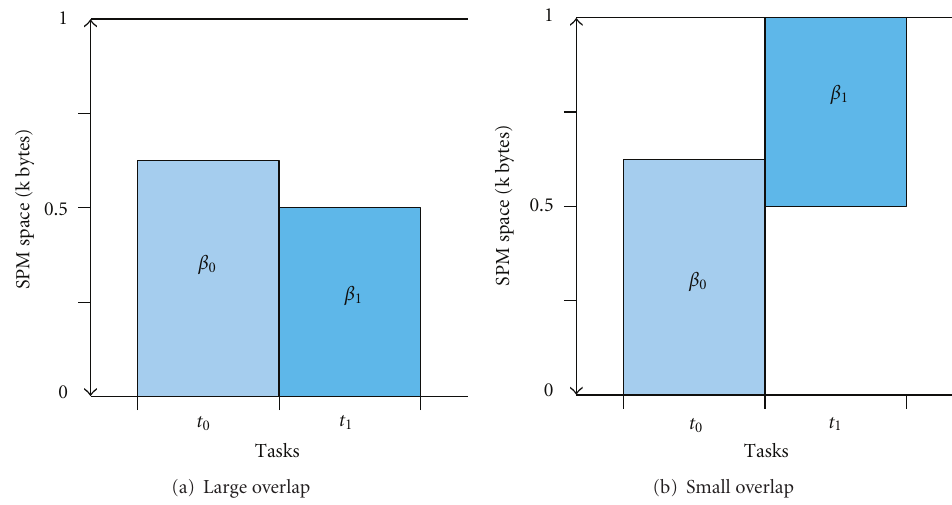
Figure 10: E ff ect of the blocks’ address on overlaps.